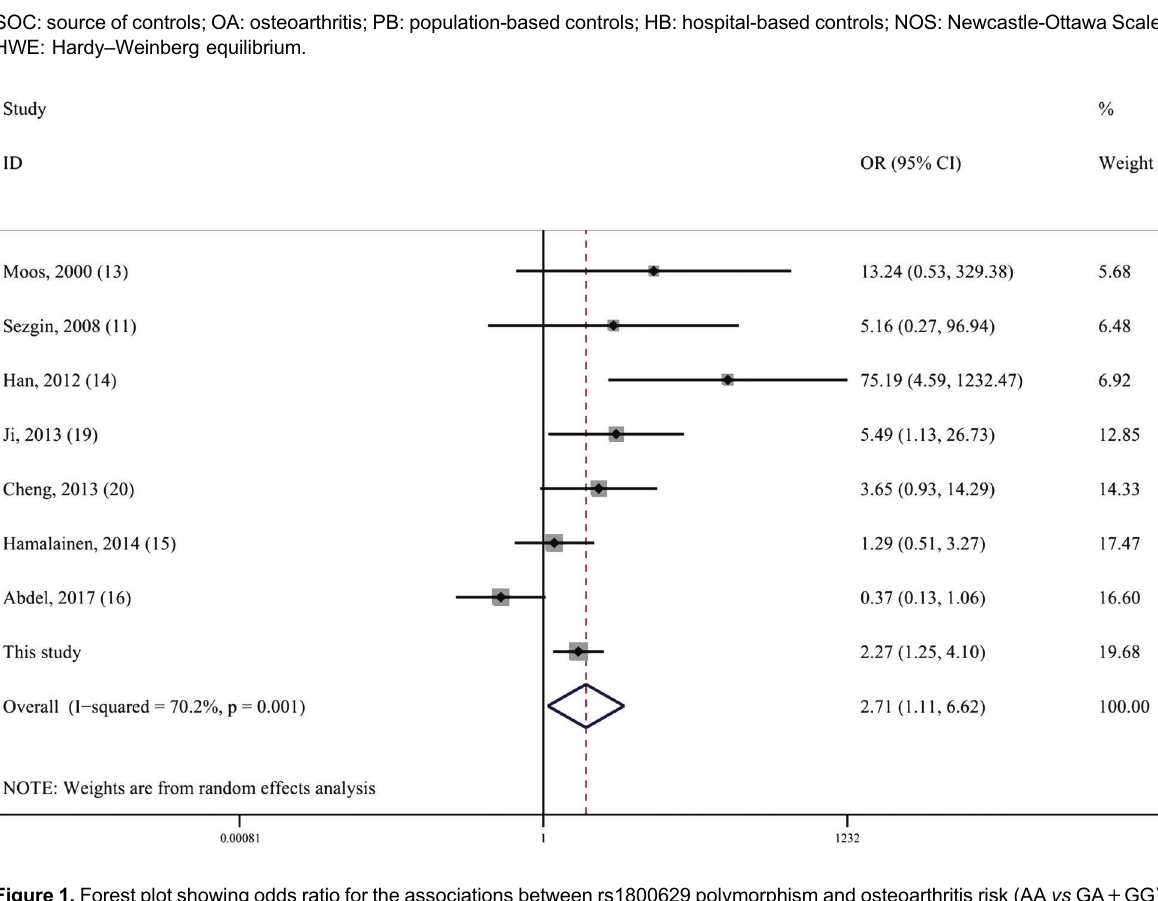
Figure 1. Forest plot showing odds ratio for the associations between rs1800629 polymorphism and osteoarthritis risk (AA vs GA +